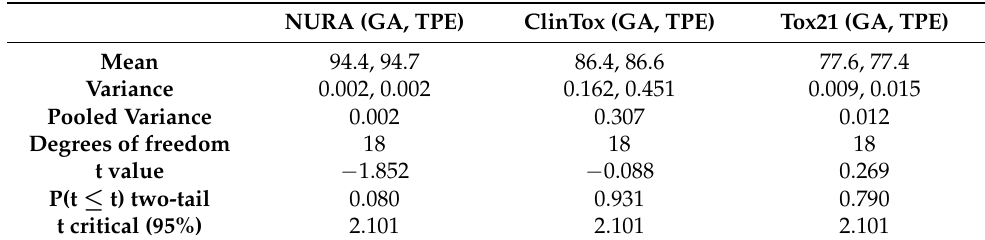
Table A5. Two-tailed t-test with a hypothesized zero mean difference for the three datasets consider- ing the best result among 10 replicas between genetic algorithms (GA) and tree-structured Parzen estimator (TPE) on an external test set. Variances were assumed equal.